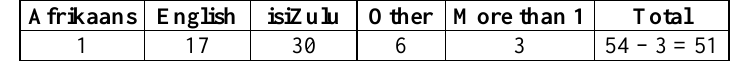
Table 2: Home language of